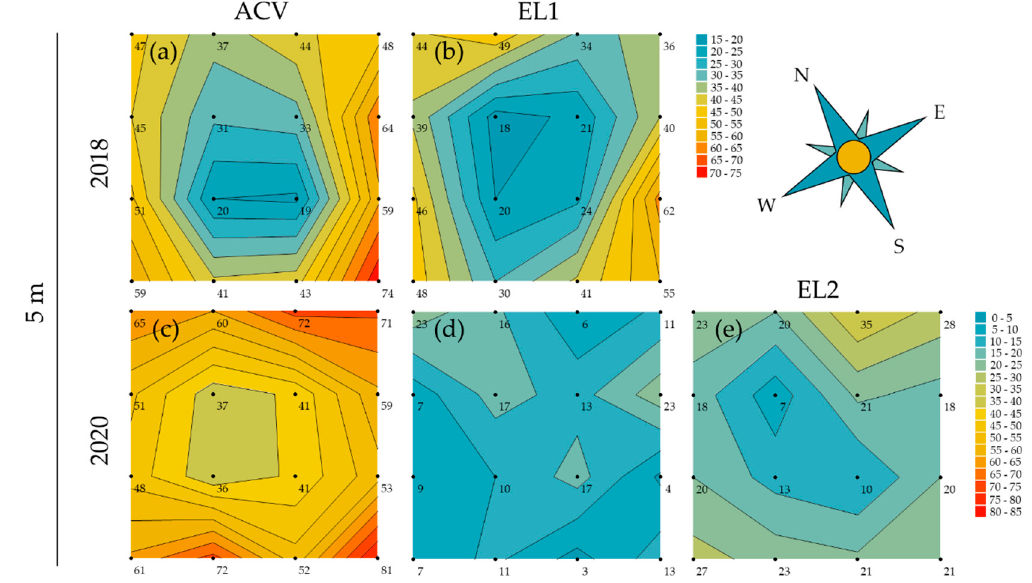
Figure 3. Contour plots for the trials in spring at 5 m inter-trap spacing. Each point of the 4 × 4 grids represents the pooled D. suzukii (male and female) trap catches for a trap position over the whole spring (May and June) trial period and the four replicate grids. The contour plots for ( a ) ACV and ( b ) EL1 in 2018 both show a clear depression in the centre of the grid. The plots are relatively symmetrical and there is no evident relation with the mean NNW winds. In 2020, the contour plots of ( c ) ACV and ( e ) EL2 again show a similar depression in the centre whereas this is not seen for ( d ) EL1. Additionally, here no evident relation with the mean wind direction (WSW) can be observed.